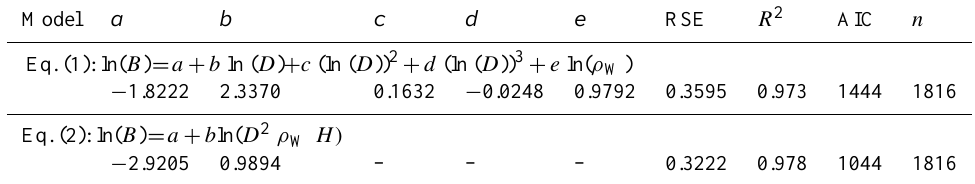
Fig. 2. (a) Distribution of destructively sampled aboveground tree dry mass (bars) by diameter class (cm) and cumulative biomass (line) on the second axis. Numbers above the bars indicate the number of trees sampled. The dataset represents the pantropical destructive data to date used to form biomass allometric models, including additional data from Africa, Asia, and South America. (b) Relative error associated with estimating the true (destructively) sampled aboveground tree dry mass (( B estimated – B measured ) / B measured ) for the same dataset estimated with and without estimated H in the biomass model by diameter class (cm). Height estimated by three model forms and either a continental or regional parameterisation. Positive values indicate the biomass model overestimates true destructively sampled mass. Table 1. Pantropical models to estimate dry biomass (kg) from Eq. (1), diameter ( D , cm) and wood specific gravity ( ρ W , gcm − 3 ), and Eq. (2), also including tree height ( H , m) for trees in pantropical forests; including the residual standard error (RSE), Akaike information criterion (AIC) and number of trees ( n ) based on destructively sampled moist forest tree data from Africa, Asia, and South